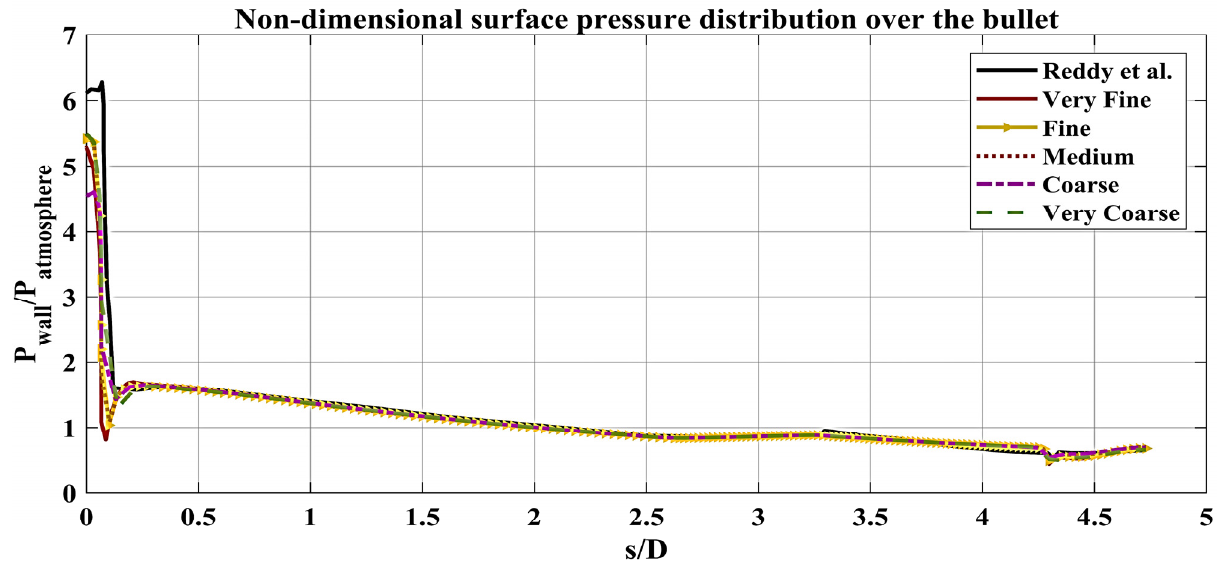
Figure 5: Grid Independence Test for surface pressure distribution over the bullet